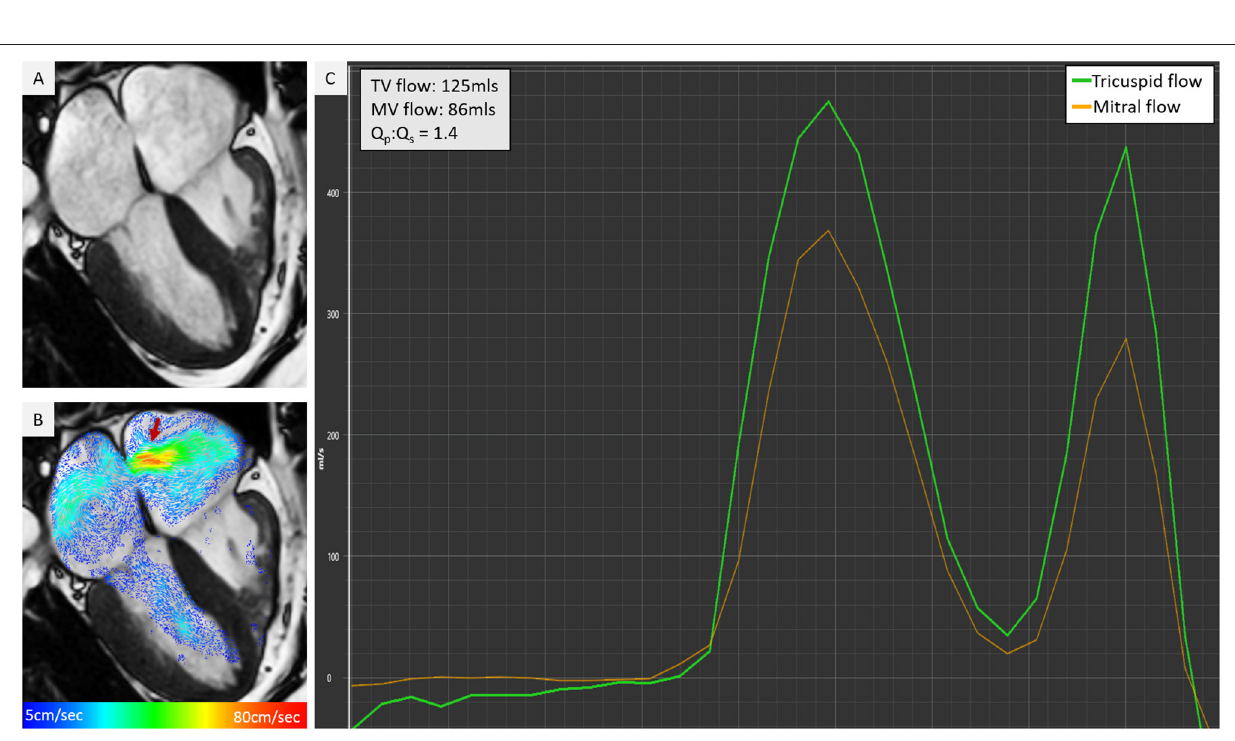
Frontiers in Cardiovascular Medicine | www.frontiersin.org